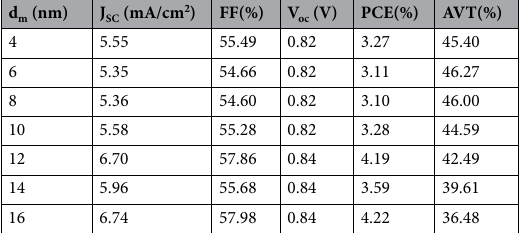
Table 3. The calculated characteristic parameters of the ITO/ZnO/PBDB-T:ITIC/MoO 3 /Ag/MoO 3 structures with D/M/D layers thickness of (10 nm/d m /30 nm). The thickness of PBDB-T:ITIC active layer is fixed at 53